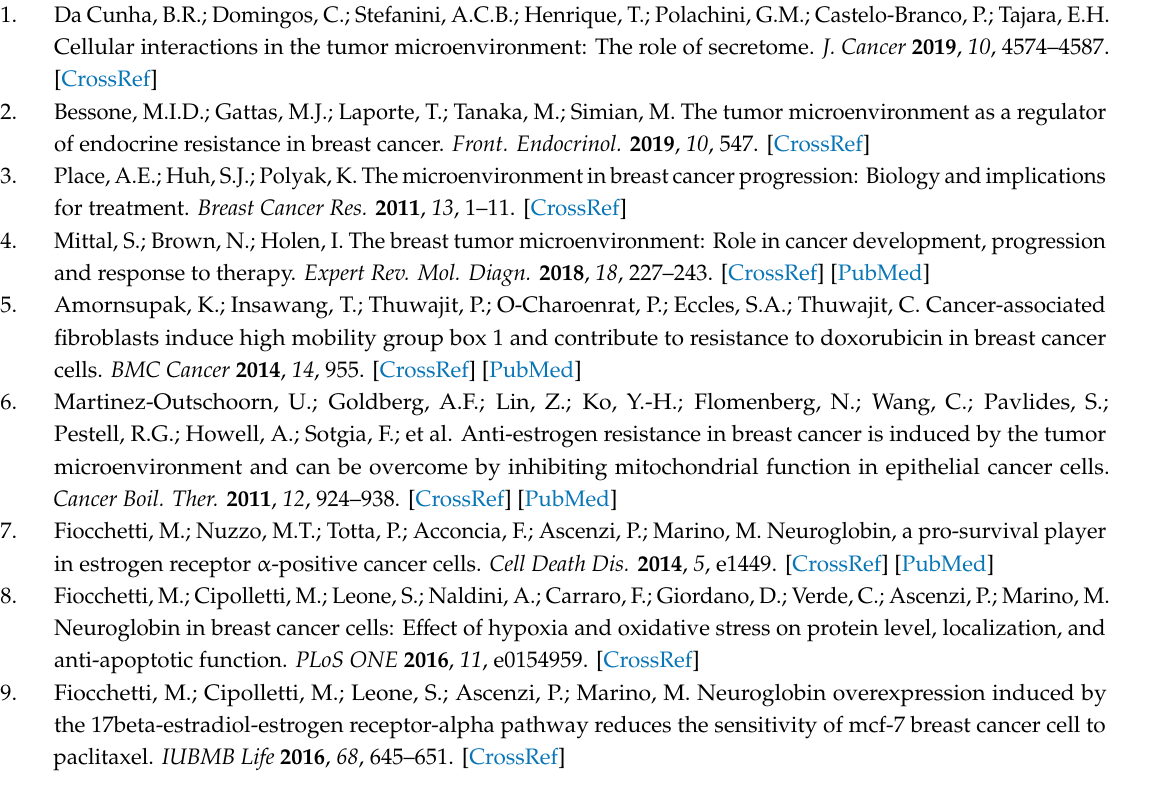
Figure S1: Graphic representation of experimental protocol for the generation of conditioned media (for details see Section 4), Figure S2: Whole blots images from Figure 2, Figure S3: Whole blots images from Figure 3B,C, Figure S4: Whole blots images from Figure 4B,D,F, Figure S5: Whole blots images from Figure